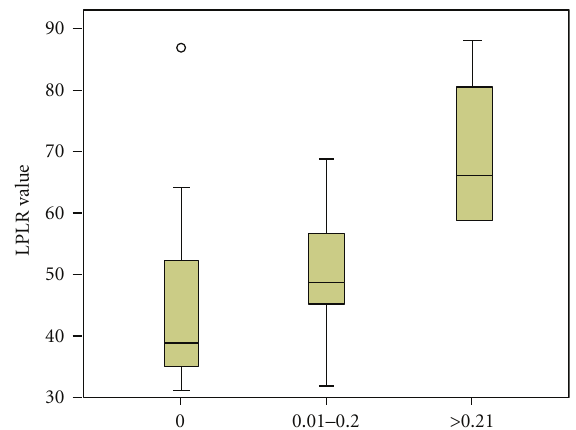
Figure 6: LPLR values according to infiltrated/retrieved lymph node ratio